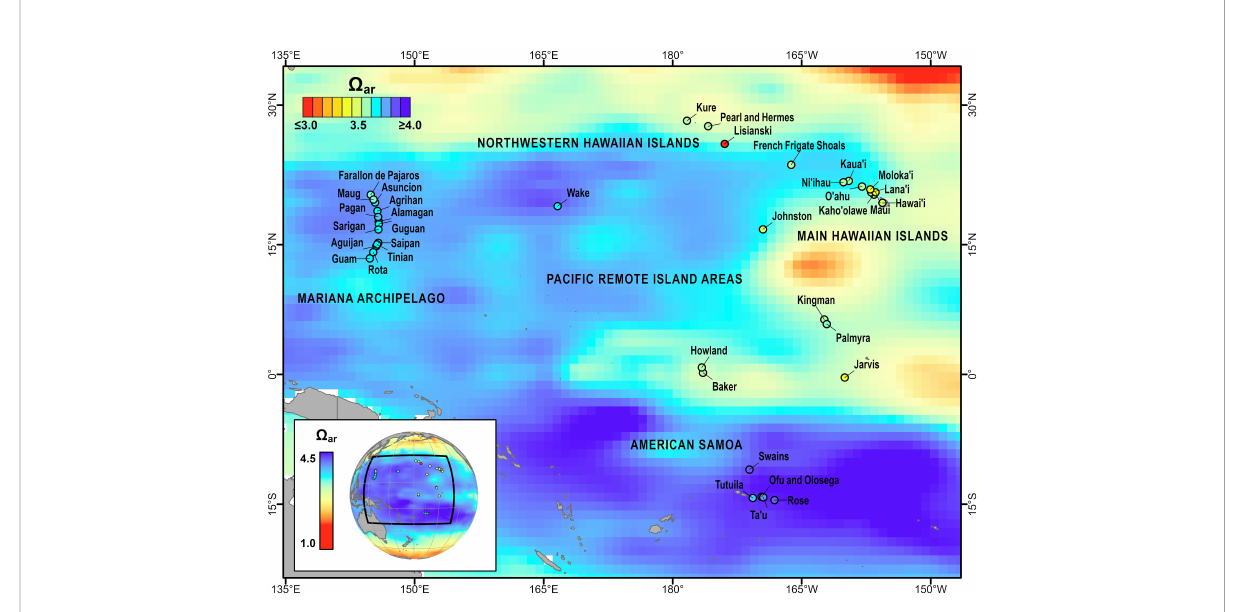
FIGURE 1 Climatological aragonite saturation state ( W ar ) for the U.S. Paci fi c Islands region from the GLobal Ocean Data Analysis Project (GLODAP, 1973 – 2013) v2 (Lauvset et al., 2016), shown with global climatological W ar (inset). Islands and atolls surveyed as part of NOAA ’ s Paci fi c RAMP/NCRMP are shown as points, with shading corresponding to the average 2010 – 2019 mean in situ W ar . Modi fi ed and updated from Figure 6.3 in Jewett et al.,